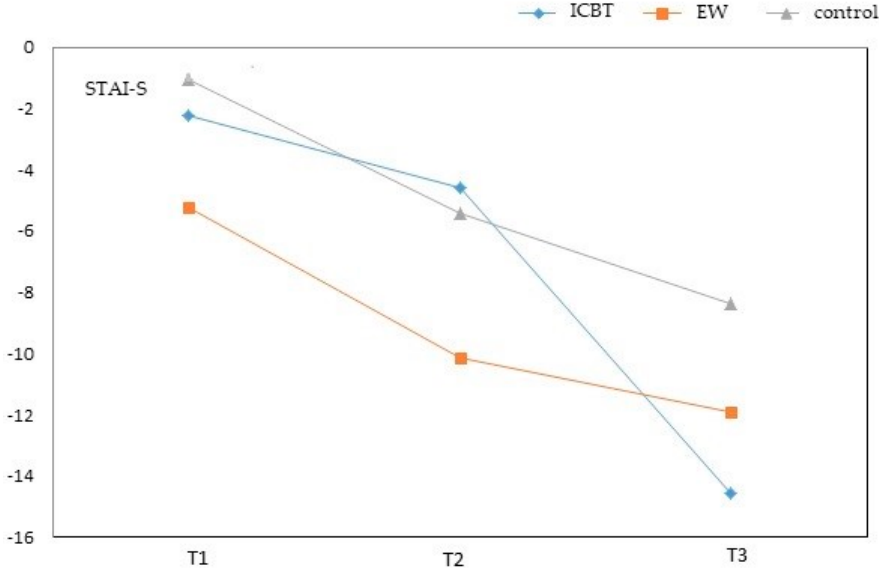
Figure 2. Adjustment mean change of STAI-S over time. Adjustment mean was estimated using the ANCOVA model in Table 2. T1 = assessment at 2 weeks, T2 = assessment at 6 weeks and end of practicum, and T3 = assessment at 18 weeks.